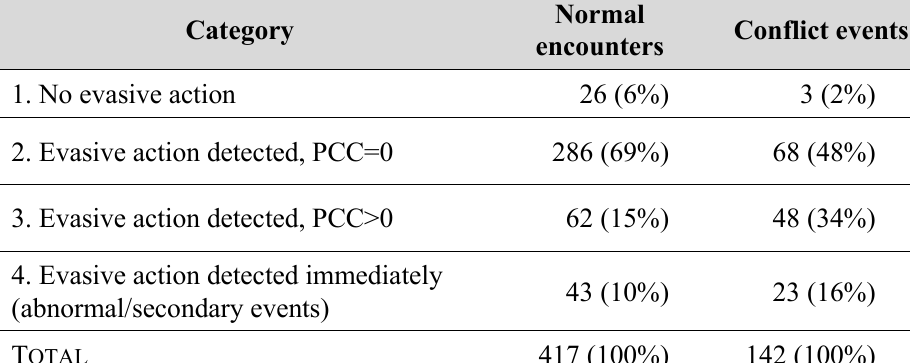
Table 3 Event distribution from the two datasets by four